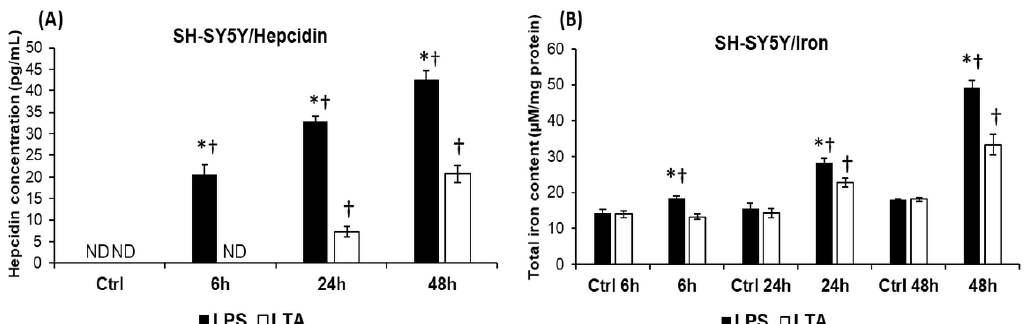
Figure 3. Effects of LPS and LTA treatments on hepcidin secretion and on iron content of SH-SY5Y cells. Hepcidin content of cell culture supernatants was determined with Hepcidin 25 bioactive ELISA Kit. The hepcidin contents of the control media did not change during the experiments therefore only one control was represented in Figure A. Intracellular iron contents of SH-SY5Y cells were determined using a colorimetric ferrozine-based assay. Iron contents of the untreated control cells were measured the same way and at the same time points of the experiments (6 h, 24 h, and 48 h). ( A ) Hepcidin concentrations in the cell culture media of the LPS and LTA treated SH-SY5Y monocultures. ( B ) Total iron contents of LPS and LTA treated SH-SY5Y cells. The columns represent mean values and error bars represent standard errors of the mean (SEM) of four independent determinations. ND stands for not detected. Asterisk marks p < 0.01 between LPS and LTA treatments. Cross marks p < 0.01 compared to the untreated controls.